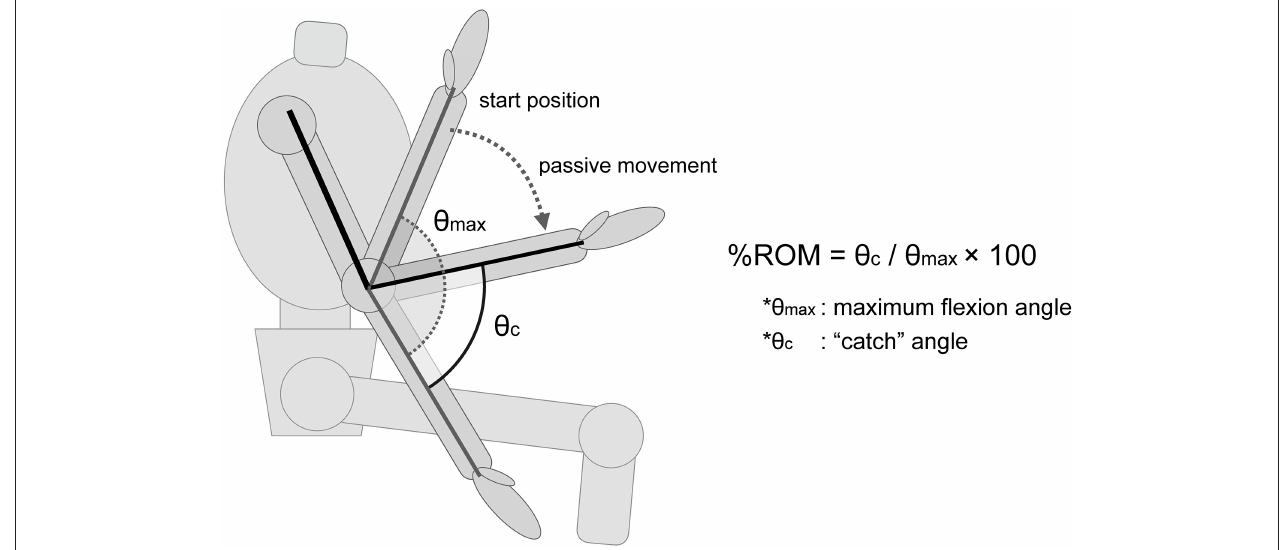
FIGURE 1 | Description of the %ROM. The %ROM was calculated as the ratio of the angle at which the “catch” of the spasticity occurs. θ max, maximum flexion angle of the elbow joint. θ c, the angle at which the “catch” of the spasticity muscle occurs.